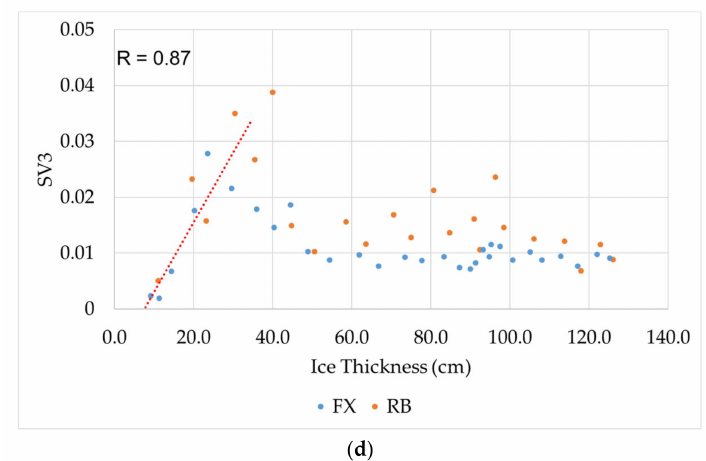
Figure 7. Temporal evolution of the Stokes elements with ice thickness for ( a ) SV0, ( b ) SV1, ( c ) SV2, and ( d ) SV3. Red trend line is included for values in the range sensitive to ice thickness. R is the correlation coe ffi cient of linearly regressed data.